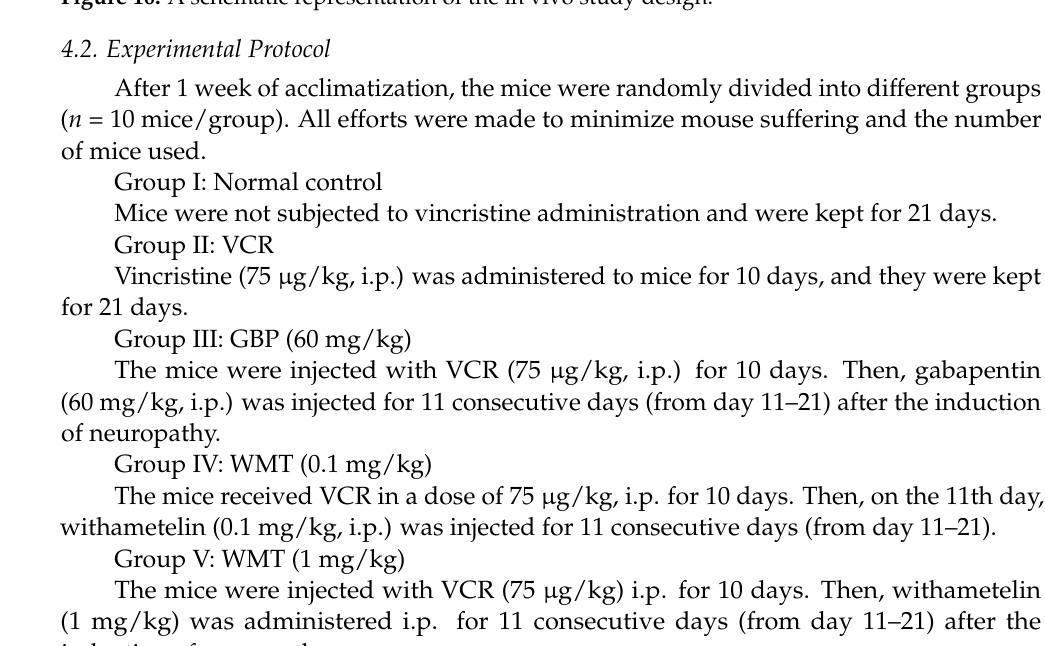
Figure 16. A schematic representation of the in vivo study design.